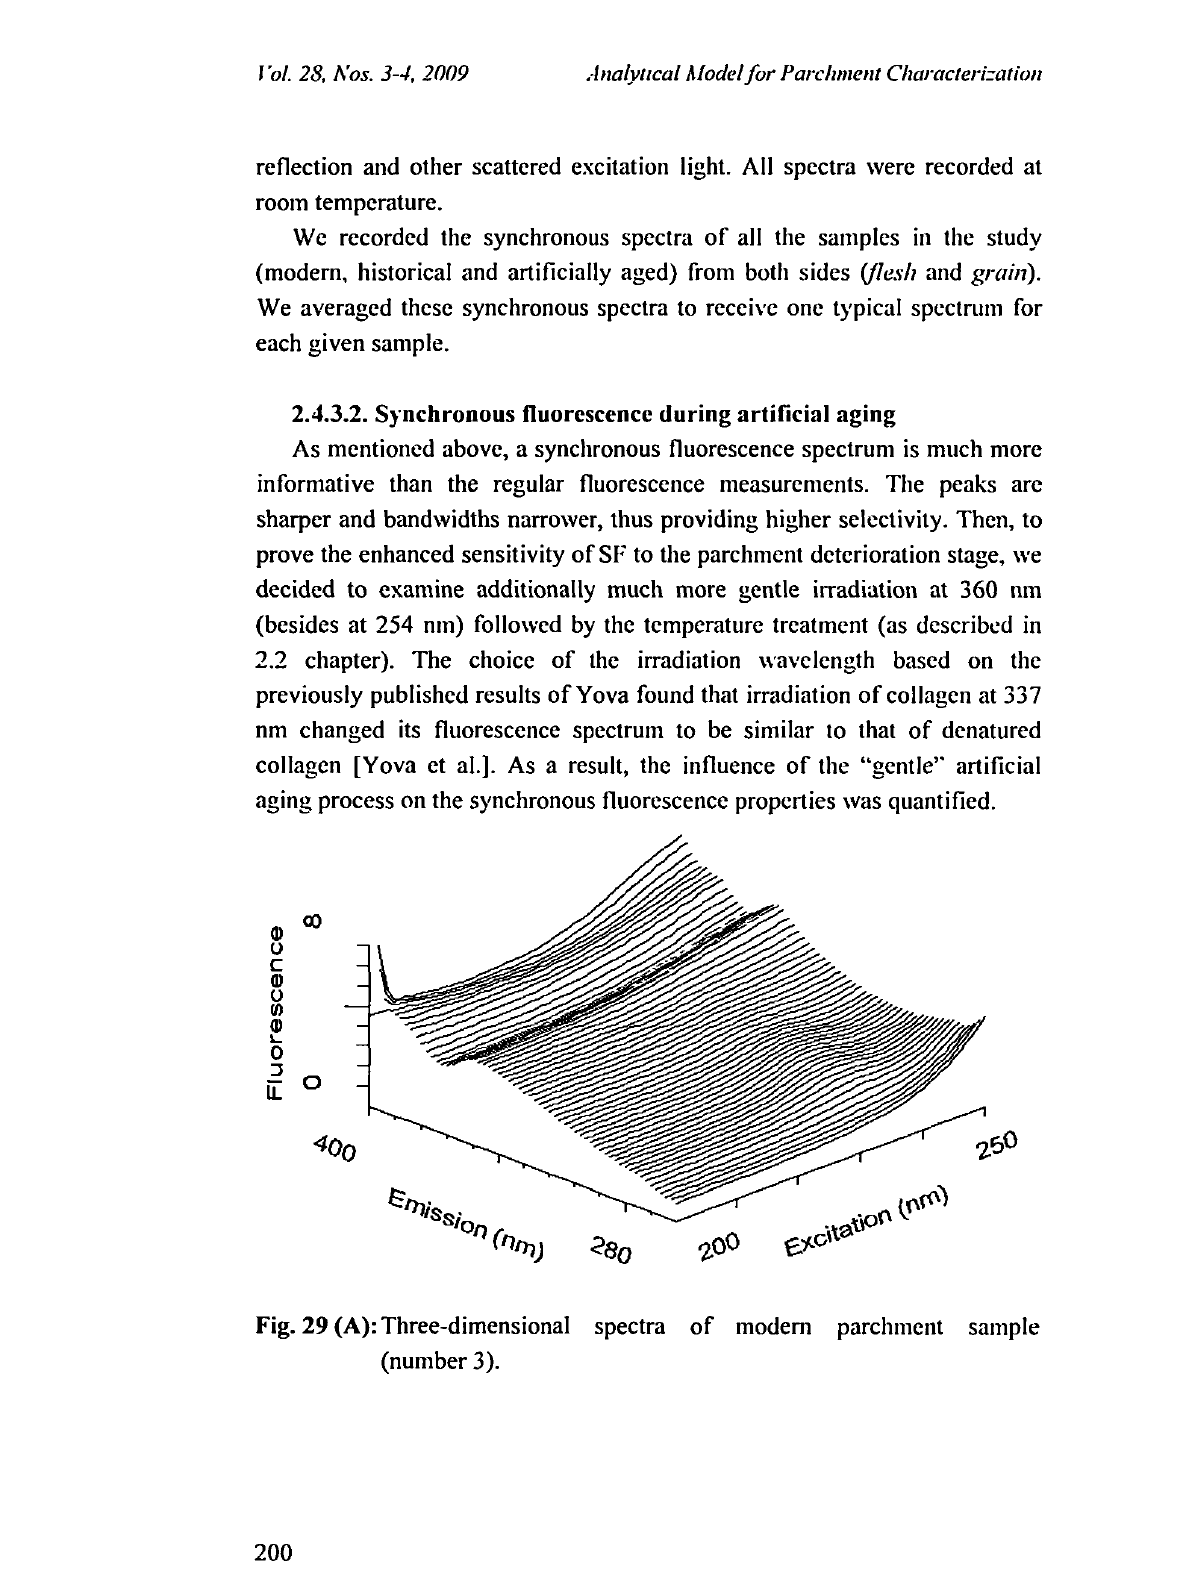
Fig. 29 (A): Three-dimensional spectra of modern parchment sample (number